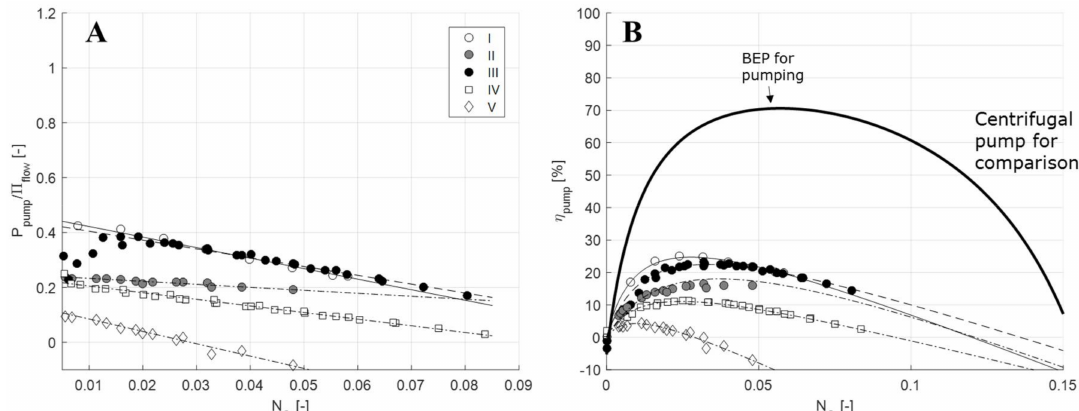
Figure 5. ( A ) Plot of Equation (11) to determine the pump constants c 1 and c 2 for the five mixers in Table 1. ( P pump denotes the pumping power of the mixer and Π flow denotes the flow-term in the power-draw correlation, see Section 5.2.) ( B ) Pumping efficiency ( η pump ) as a function of the flow number ( N Q ) for the five mixers, compared to data for a typical centrifugal pump. Data from [27,34,36]. See Reference [35] for the